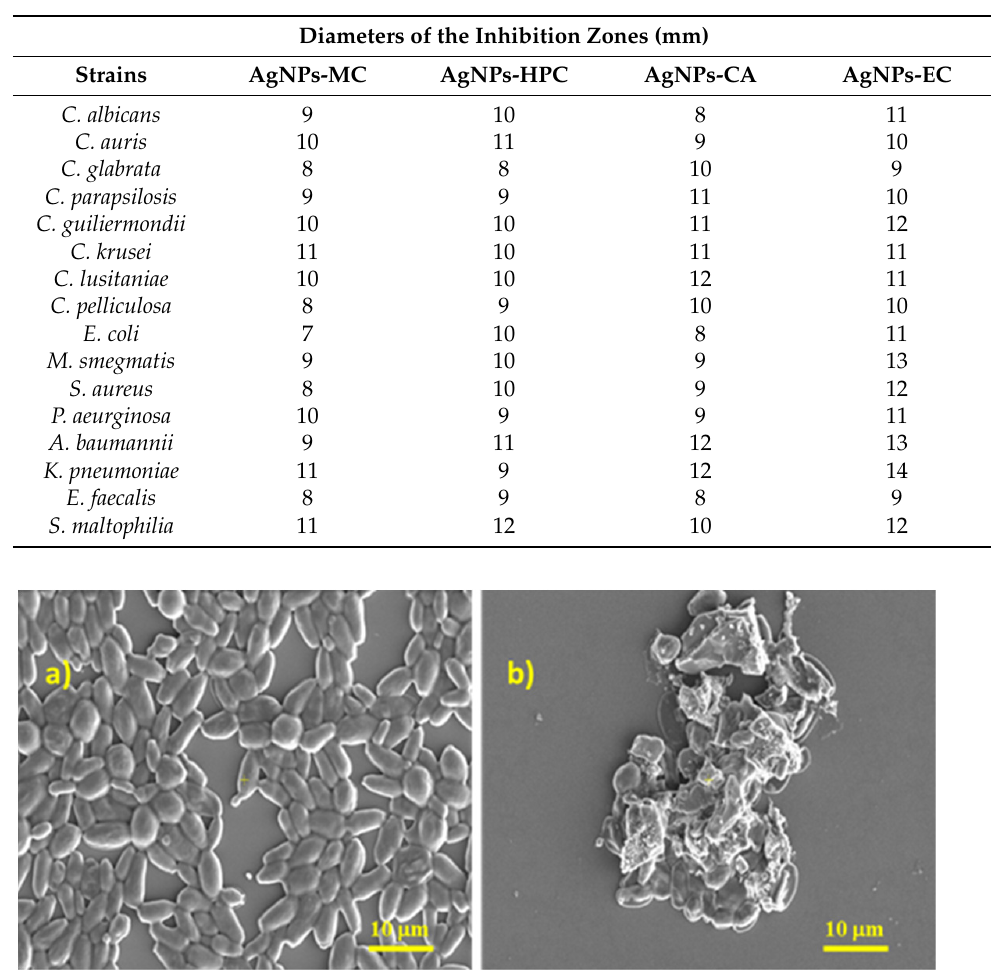
Figure 7 . Visualization of the effects of AgNPs on C. albicans using advanced Scanning Electron Microscopy; ( a ) SEM micrographs of C. albicans without treatment, cells are well-defined, with a smooth surface and oval shaped; and ( b ) C. albicans after AgNPs treatment showing distortion, roughness, and disruption on the cell wall of the yeast